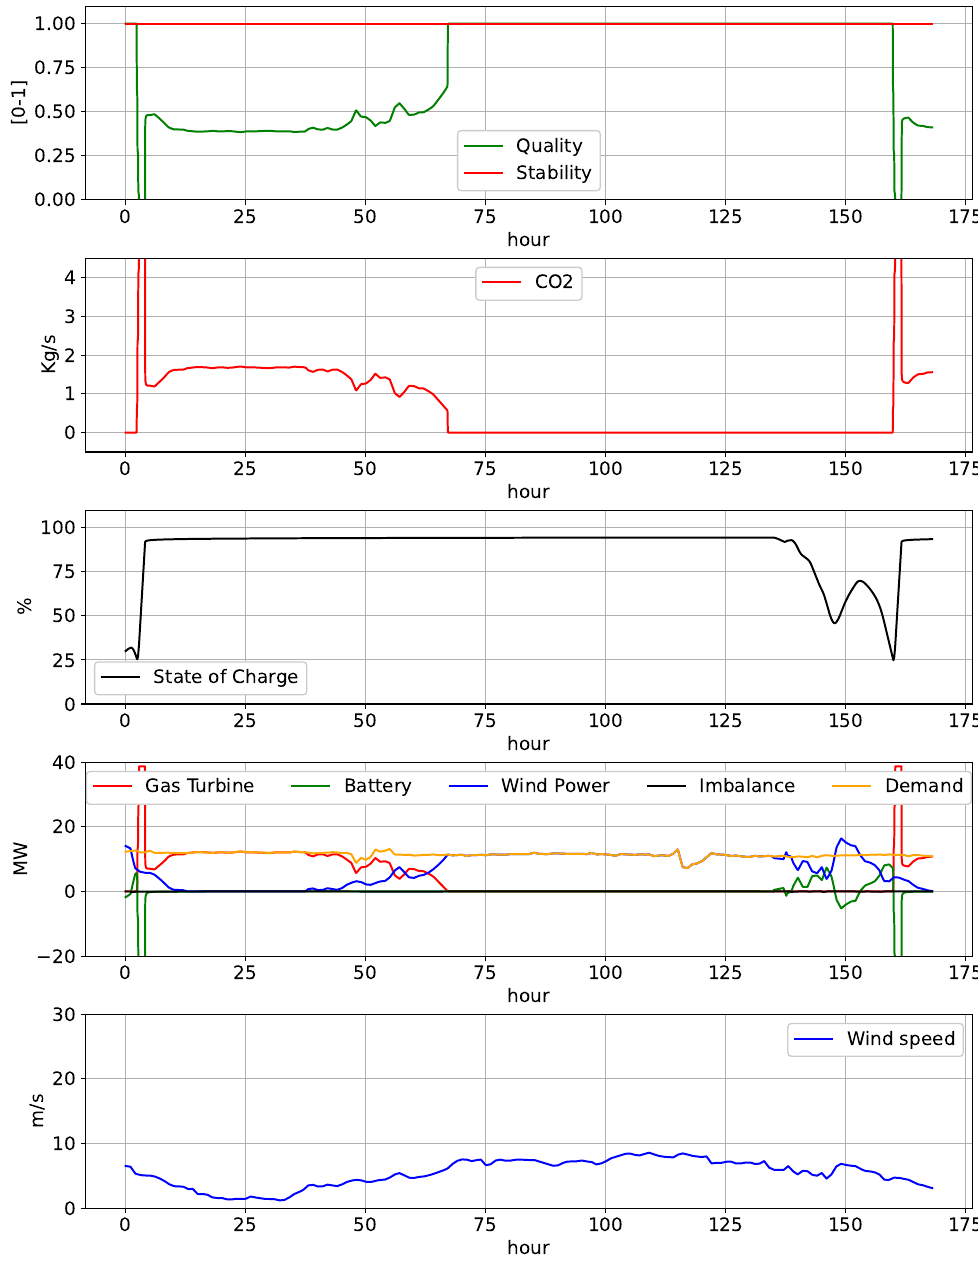
Figure 19. Strategy 4 with low wind speed